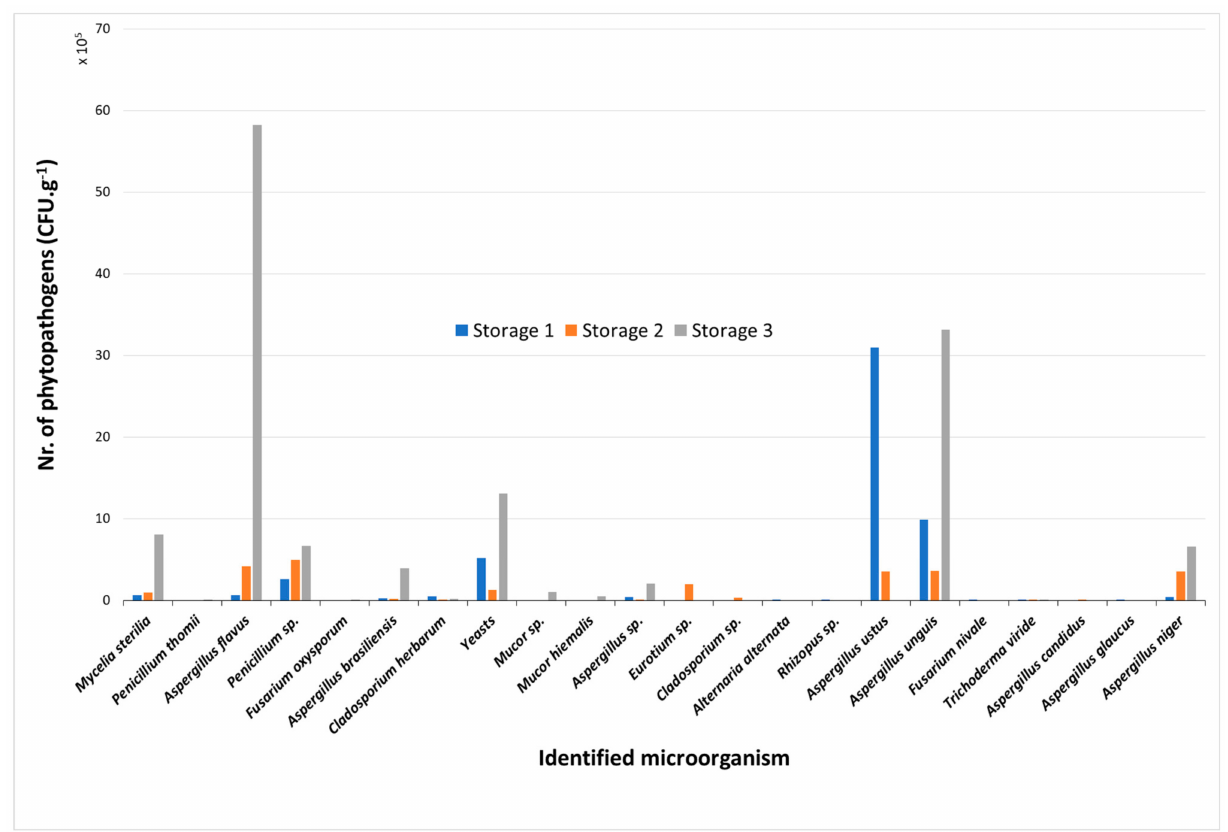
Figure 8. Identified phytopathogens and their number at individual sampling points from surface samples of stored